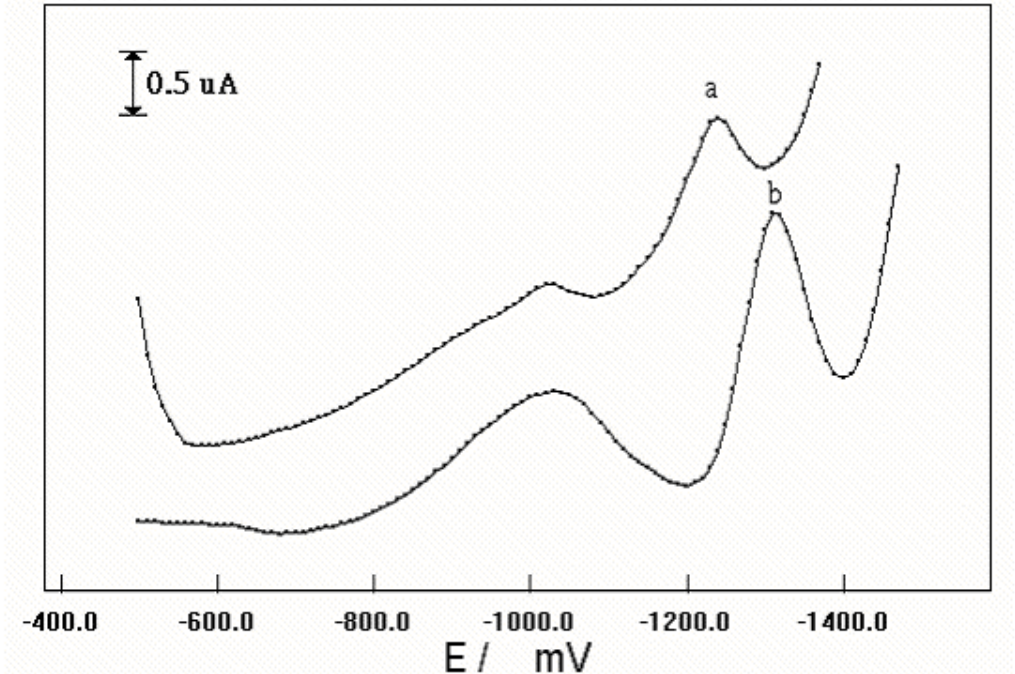
Figure 4. Differential pulse voltammograms of NDELA (16 mg/l) for different modified electrodes in LiClO : (a) Pb (4 mM)/GCE; and (b) Hg (4 mM)/Au, Scan rate 10 mV/s; 4 pulse height 50